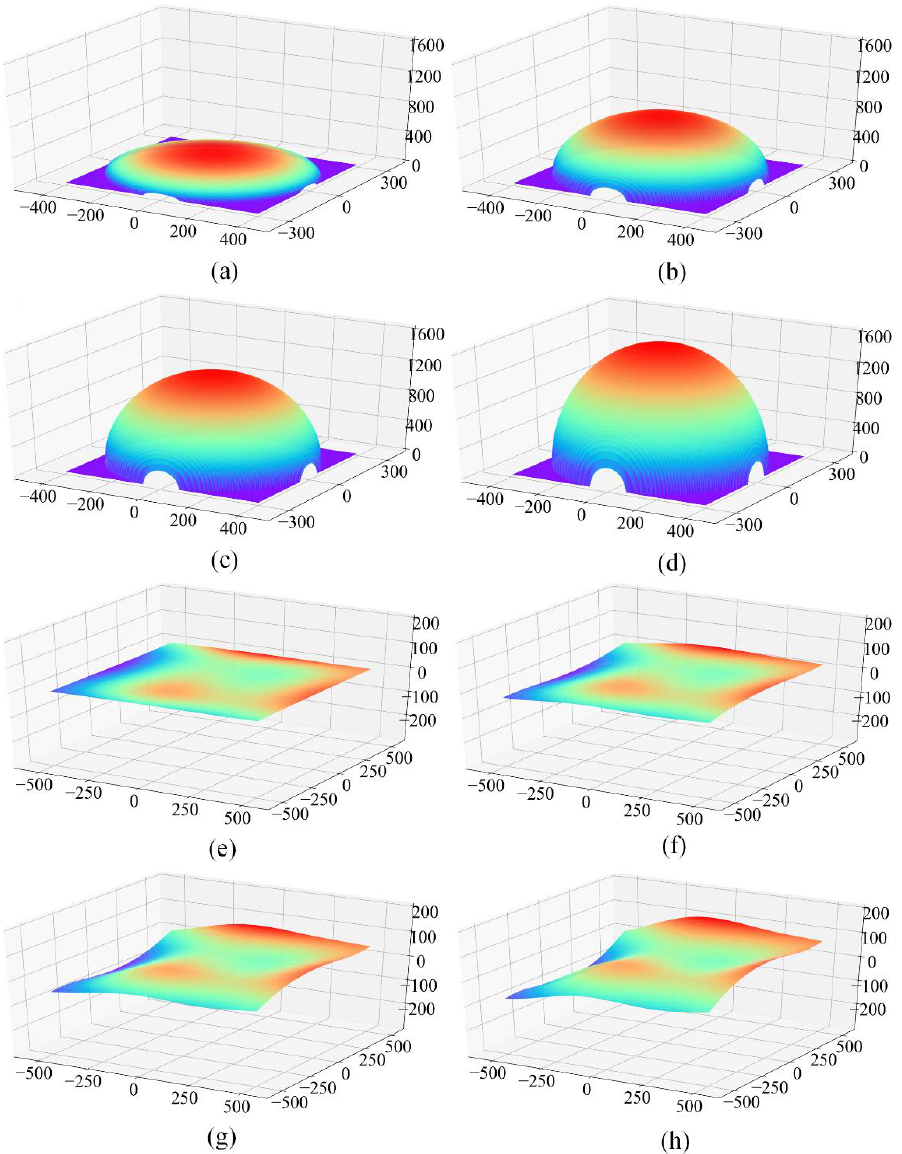
Figure 8. DEMs generated from four ellipsoid and four Gauss surfaces with various parameters: ( a ) E1, ( b ) E2, ( c ) E3, ( d ) E4, ( e ) G1, ( f ) G2, ( g ) G3, and ( h ) G4. The color indicates the change in elevation over the DEM. Table 3. Complexity parameters of the eight mathematical surfaces (DEM resolution = 5 m).